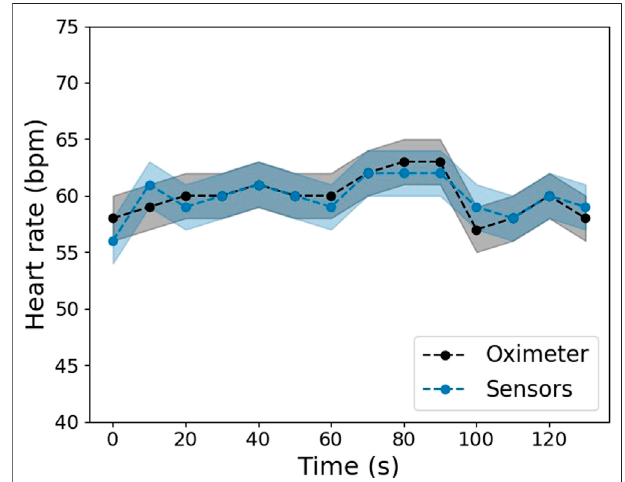
FIGURE 11 | Comparison of the heart rate values obtained by the developed system's sensors and a commercial heart rate meter in one volunteer.